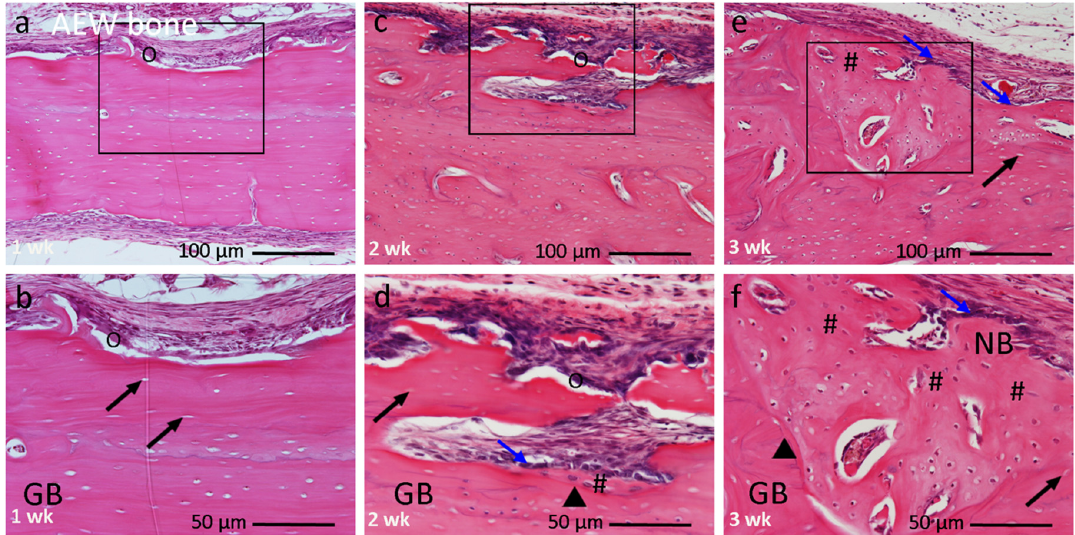
Figure 6. Histological image of AEW bone group at 1, 2, and 3 weeks after implantation, at higher magnification. ( a , b ) At 1 week graft bone encapsulated by a thick layer of mesenchymal connective tissue. Presence of trenches on outer cortical plate with multinucleated giant cells (O). ( c , d ) At 2 weeks resorption of damaged old bone. Cuboidal active osteoblast differentiation ( ) followed by new bone induction (#). ( e , f ) At 3 weeks abundant new bone induction (#) along original dead bone with irregular arrangement of new osteocytes, clearly separated by a cement line ( ). Box within a, c, e indicates focused areas in ( b , d , f ), respectively. ( a , b ) 1 week, ( c , d ) 2 weeks, ( e , f ) 3 weeks. Magnification: ( a , c , e ) 10×, ( b , d , f ) 20×. ( ) = empty lacunae, GB: graft bone, NB: new bone. Bar: ( a , c , e ) 100 μ m; ( b , d , f ) 50 μ m.